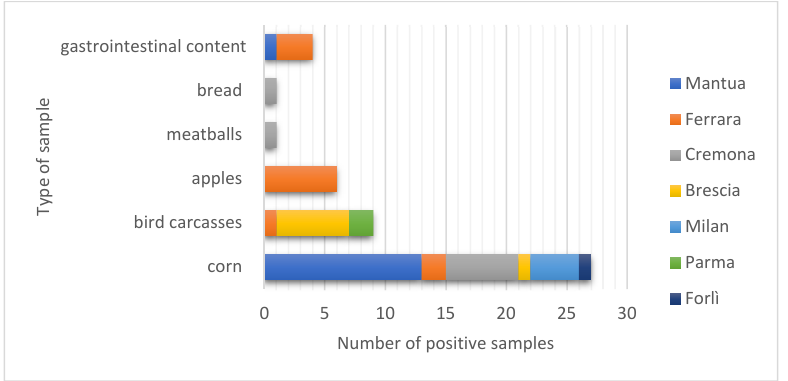
Figure 6. Number of positive samples.